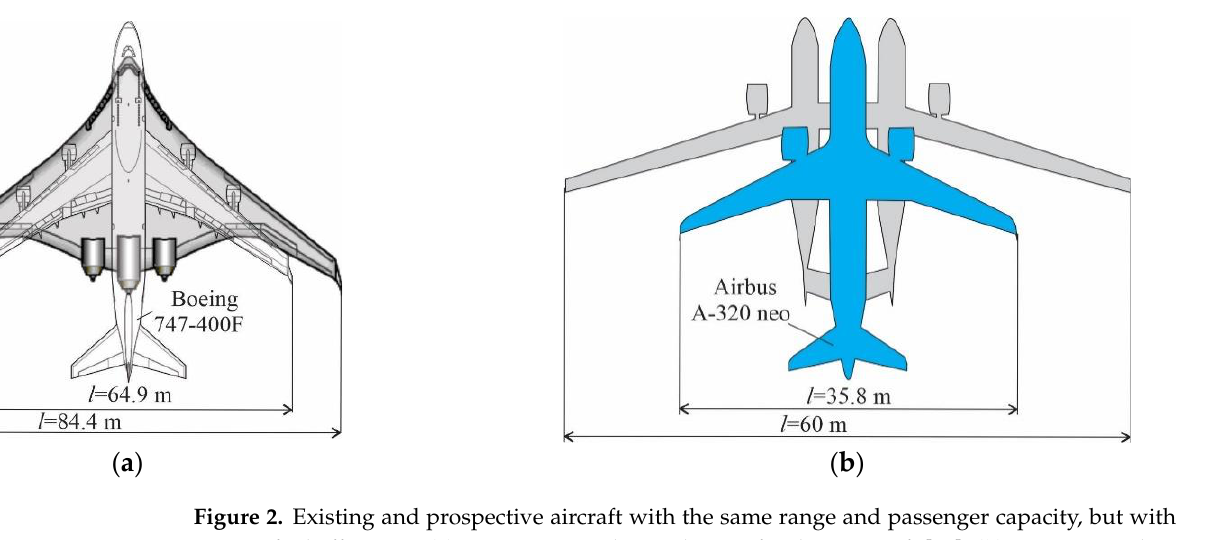
Figure 2. Existing and prospective aircraft with the same range and passenger capacity, but with greater fuel efficiency: ( a ) Boeing 747 and mixed wing-fuselage aircraft [19]; ( b ) A320neo and its two-fuselage counterpart [18].